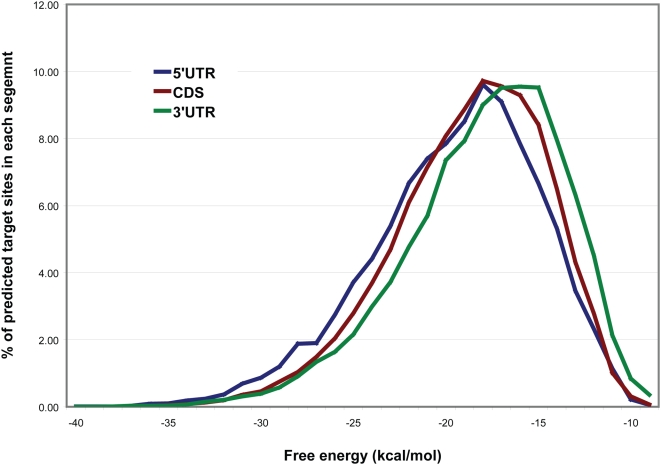
Proportion of predicted miRNA target sites (for 313 human miRNAs) as a function of free energy score, in each segment (5′ UTR, CDS and 3′ UTR) of human RefSeq mRNAs.Line smoothed for ease of interpretation.